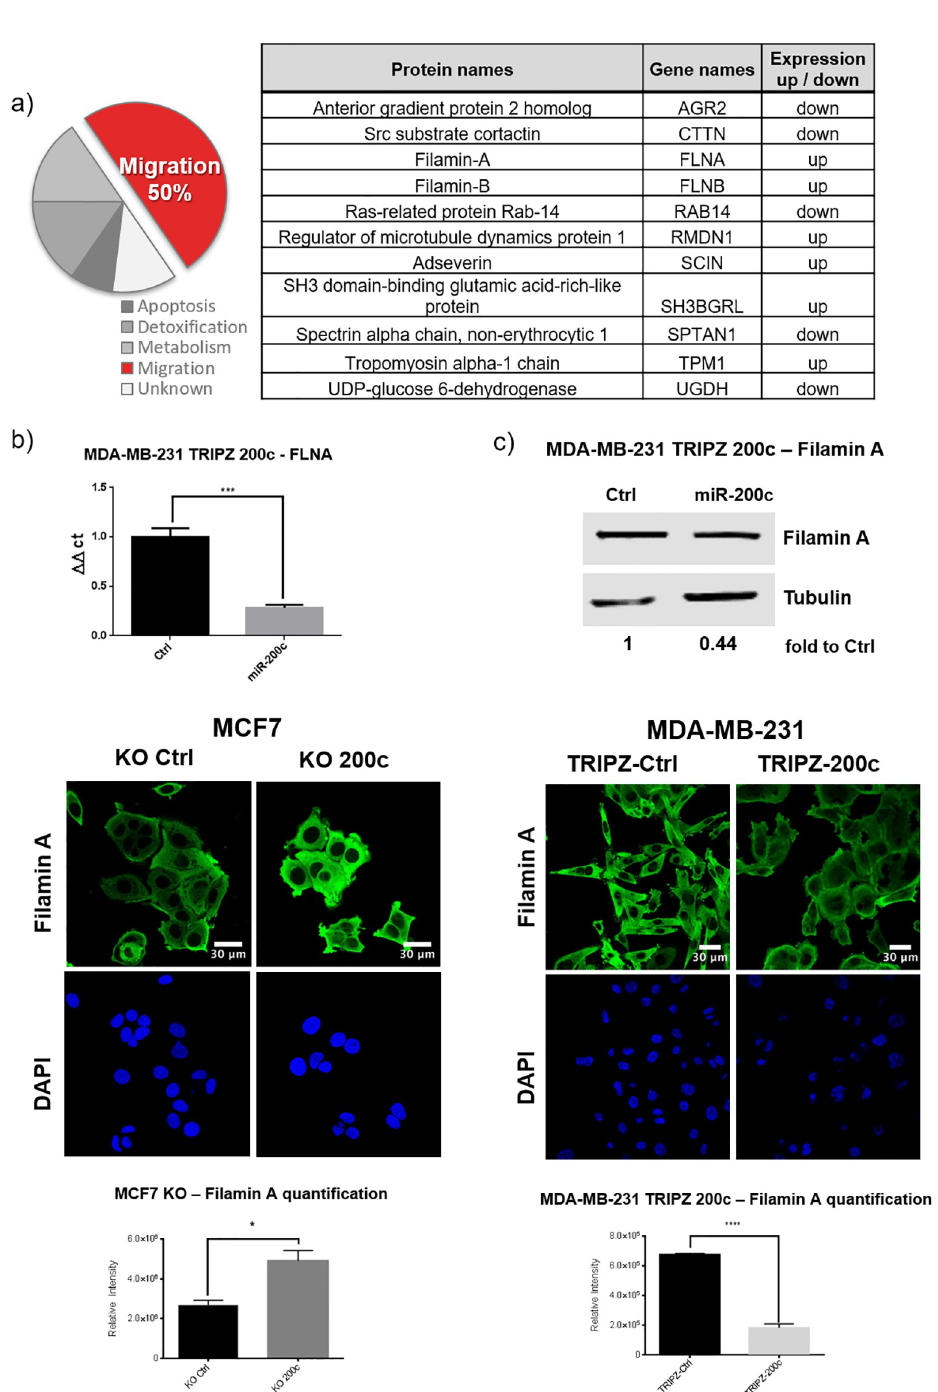
Fig 4. miR-200c regulates migration associated genes such as filamin A. (a) A proteomic analysis of a TALENs knock-out (KO) of miR-200c in MCF7 cells revealed a set of proteins with differential expression, of which 50% are involved in migratory processes and are shown in the table. (RT qPCR showed that after adding 5 μ g / ml doxycycline for 48 h the expression of FLNA mRNA (b) as well as filamin A protein(c) (normalized to tubulin) decreased significantly in MDA-MB 231 TRIPZ 200c cells. (d) Immunofluorescence staining of filamin A (green) and DAPI (blue) in MCF7 Ctrl and KO 200c showed significantly increased relative intensity of filamin A, in contrast to (e) the MDA-MB-231 cells which showed a strong decrease in filamin A intensity after induction of miR-200c (all N = 3; error bars indicate standard deviation SD; � p � 0.05, �� p � 0.01, ��� p � 0.001, ���� p � 0.0001).